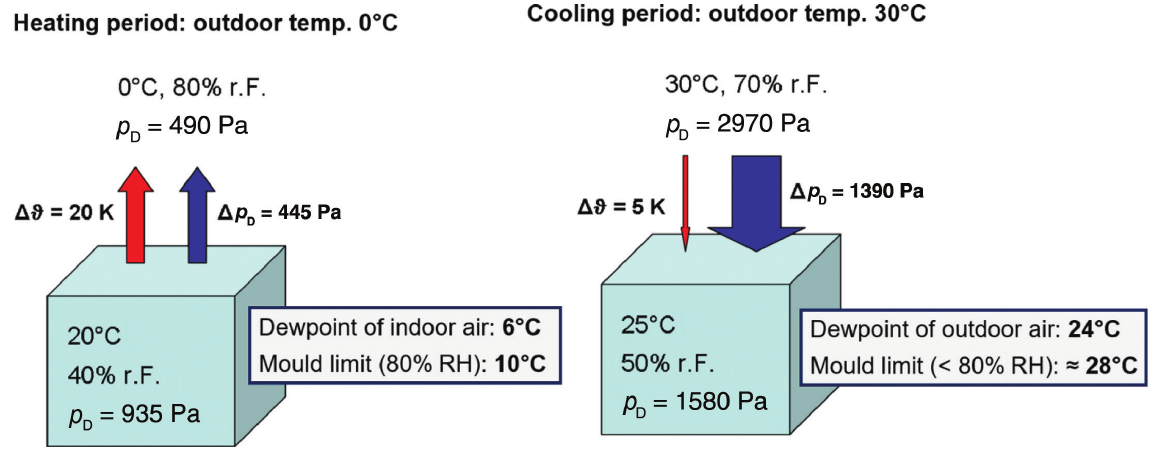
Typical temperature and vapour pressure gradients between outdoor and indoor conditions during the heating season in cold and moderate climates (left) and the cooling season in warm and humid climates